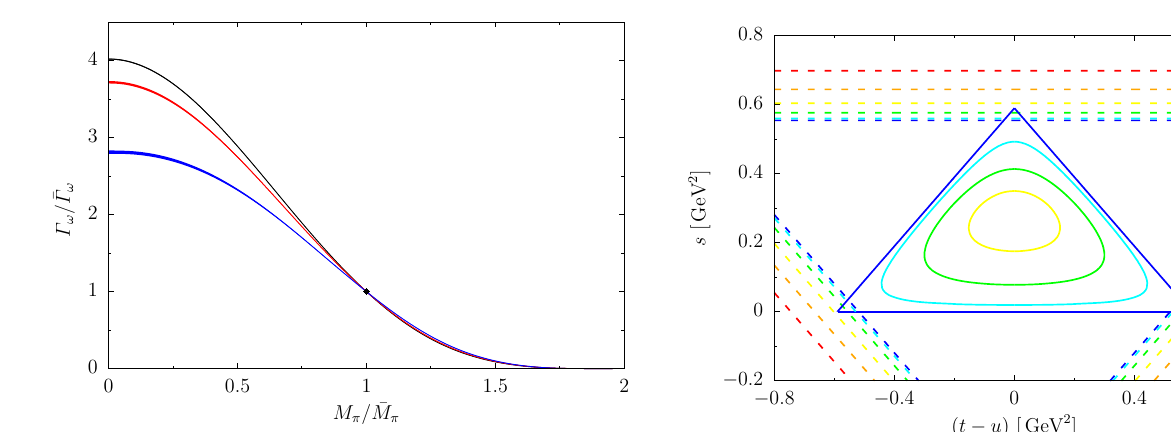
Fig. 6 Pion-mass-dependent phase space boundaries of ω → 3 π (solid lines) and position of the “on-shell” ρ in the respective s -, t -, and u -channels (dashed lines). The color coding is kept identical to ¯ M Figs. 1 and 2 with the following pion masses: 0 (blue), 1 π (cyan), 2 ¯ M ¯ M ¯ M ¯ M π (green), 3 2 π (yellow), 2 π (orange), and 5 2 π (red). For the last two the phase space already vanishes, and thus the ω becomes